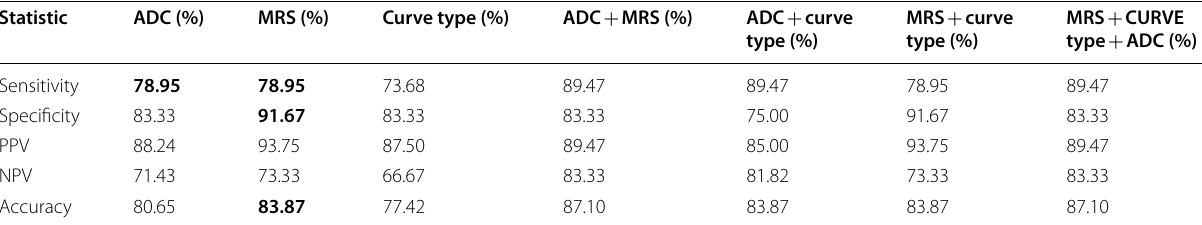
The Values in Bold are the values that clarify the solo role of the ADC values and MRS and show the relevant modality to predict complete cancer remisison